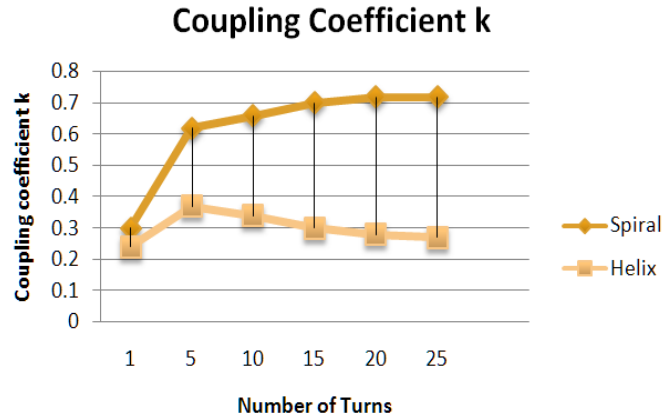
Figure 13. Coil effect on coupling coefficient.